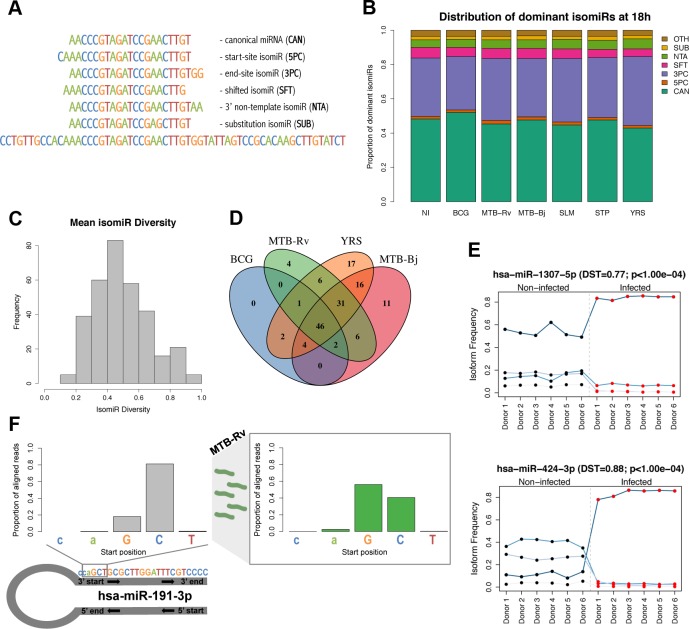
Dynamic expression of miRNA isomiRs upon infection.(A) Classification of isomiRs depending on their difference from the annotated mature miRNA sequence (based on [28]). (B) Cumulative barplots showing the proportion of miRNAs for which the dominant sequence was the canonical sequence or, instead, one of six classes of isomiR. Data shown is for 18h post-infection, for other time points see S9 Fig. (C) Histogram showing the mean miRNA diversity (expression of dominant isomiR / total expression of miRNA) across all experimental conditions. (D) Venn diagram showing the overlap of miRNAs showing a significant change in isomiR distribution upon infection with different bacteria. Due to the smaller sample size, we did not perform the analysis upon STP infection. We obtained no significant changes in isomiR distribution following SLM infection, as one individual did not respond to infection (S3 Fig.). (E) Examples of the two characteristic profiles observed for miRNAs showing a change in isomiR distribution upon infection; top: a difference in the proportional expression of each isomiR upon infection, bottom: a change in the dominant isomiR upon infection. Examples are taken from MTB-Rv infection at 48h. Each line represents an individual isomiR and the proportion of the total miRNA expression level accounted for by each isomiR, per donor, is shown before (black dots) and after (red dots) infection. Points are joined together for legibility. (F) The distribution of starting bases of reads aligning to miR-191-3p, which showed a seed shift upon infection with MTB-Rv, MTB-Bj and YRS. Before infection (left), less than 20% of reads start at the first “G” position of the canonical sequence, whereas after infection (right), over 50% of reads start at this position. Proportions of aligned reads shown in the figure are following MTB-Rv infection at 48h.